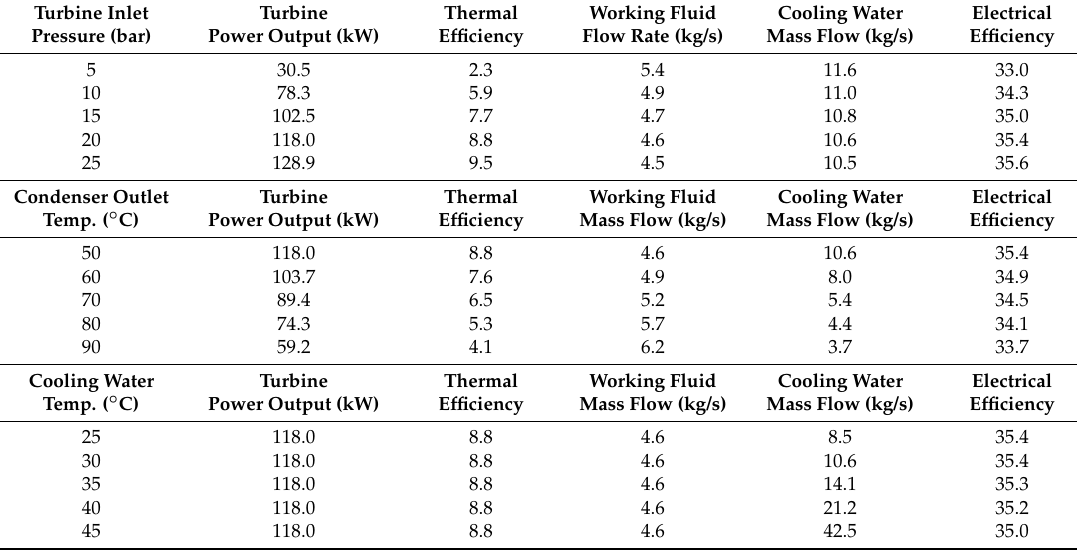
Table 8. Thermodynamic simulation results for MGT-ORC power system.